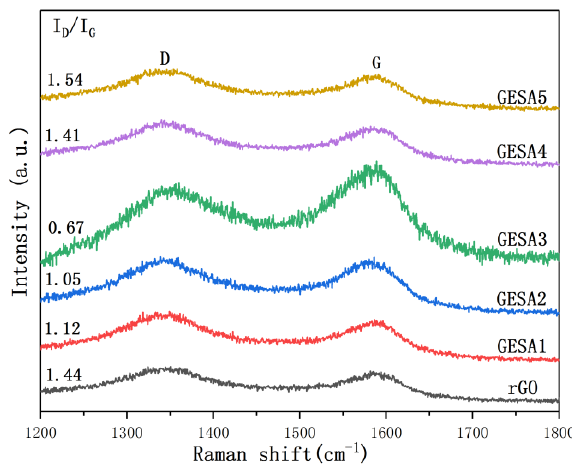
Figure 3. Raman spectra of rGO, GSA1, GESA2, GESA3, GESA4, and GESA5 composites.